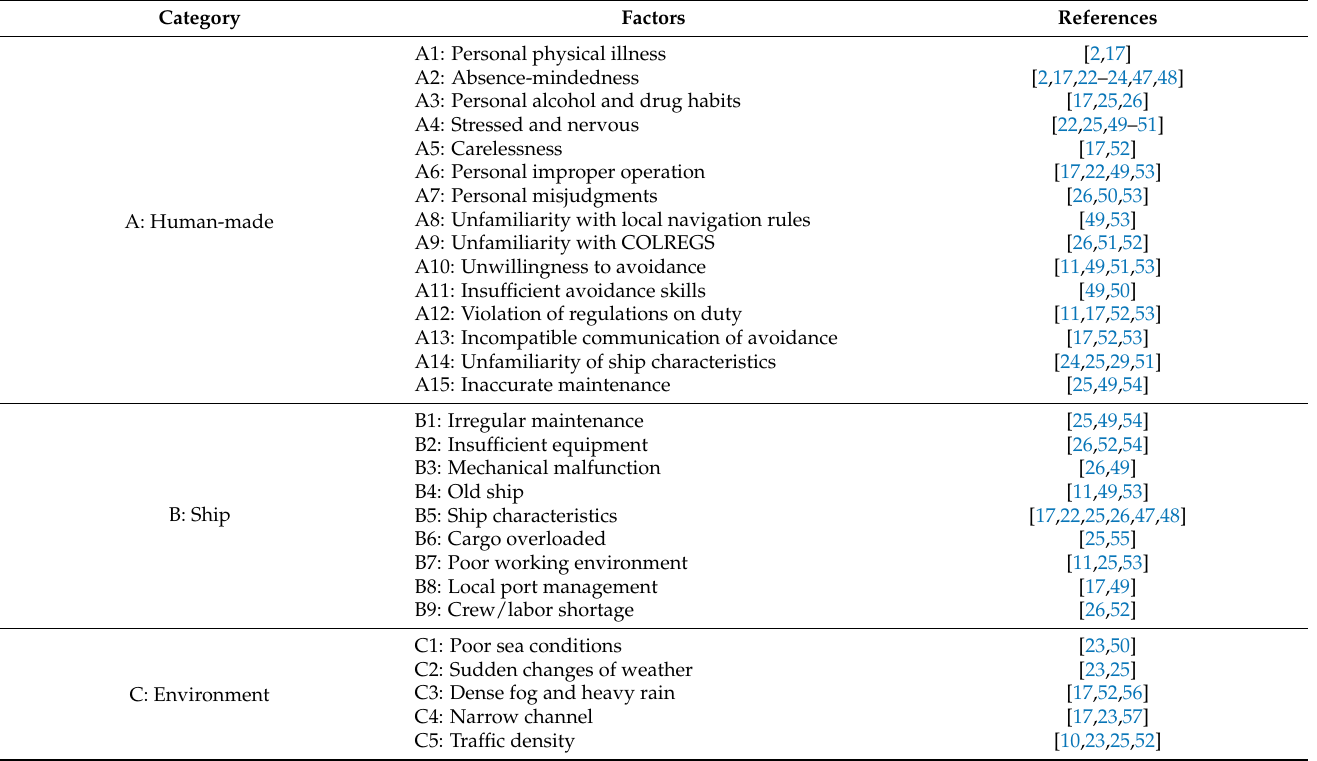
Table 2. Summary of the initial risk factors for ship